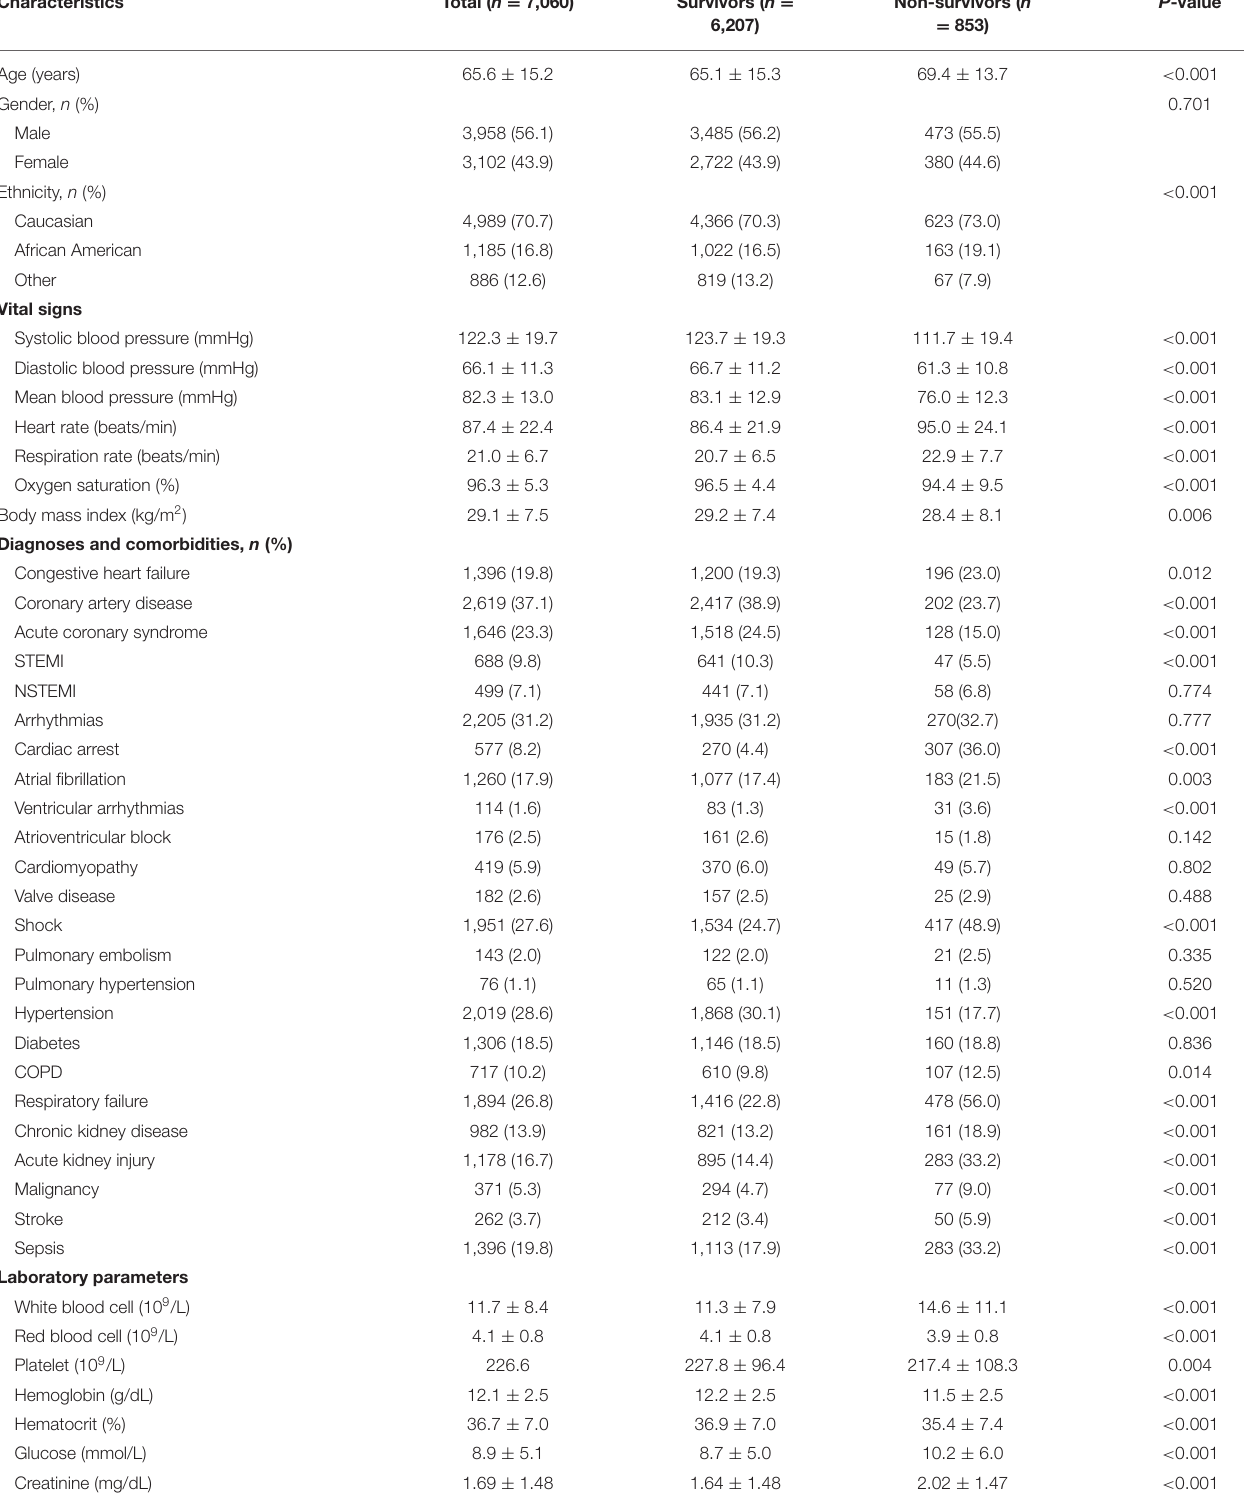
TABLE 1 | Baseline characteristics between survivors and non-survivors.